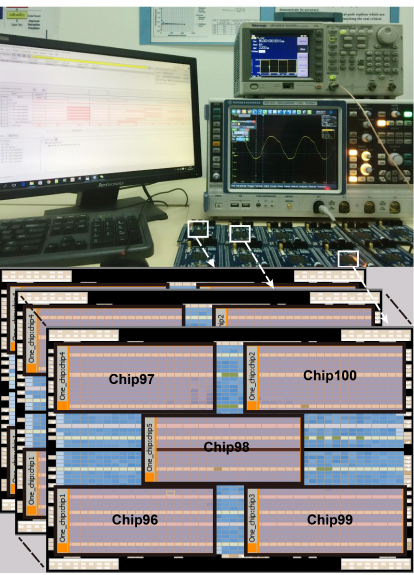
Figure 14. Overview of 28 nm FPGA (Altera 5CEFA4F23C8N) chip planner and measurement